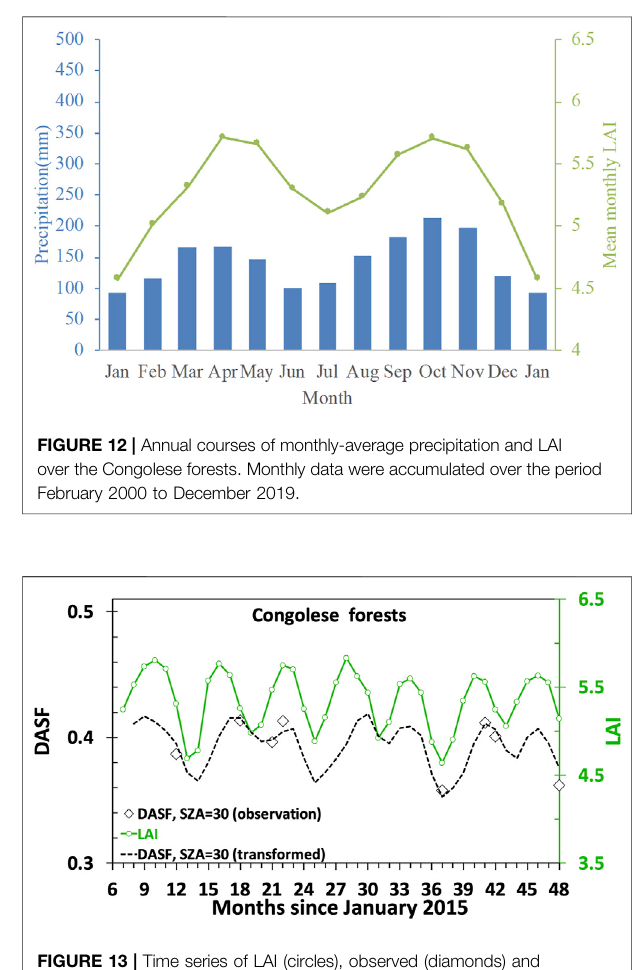
FIGURE 13 | Time series of LAI (circles), observed (diamonds) and transformed (dashed line) EPIC DASF at SZA (cid:2) 30 0 for the period from 2015 to